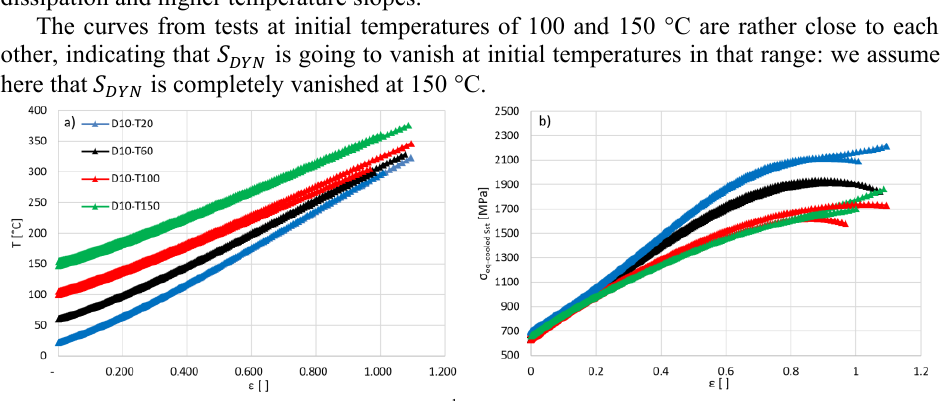
Fig. 4. Dynamic tests at the same strain rate (10 s -1 ) and different initial temperatures: (a) Temperature histories and (b) cooled equivalent curves considering only the static thermal softening 𝑆 𝑆𝑇 .